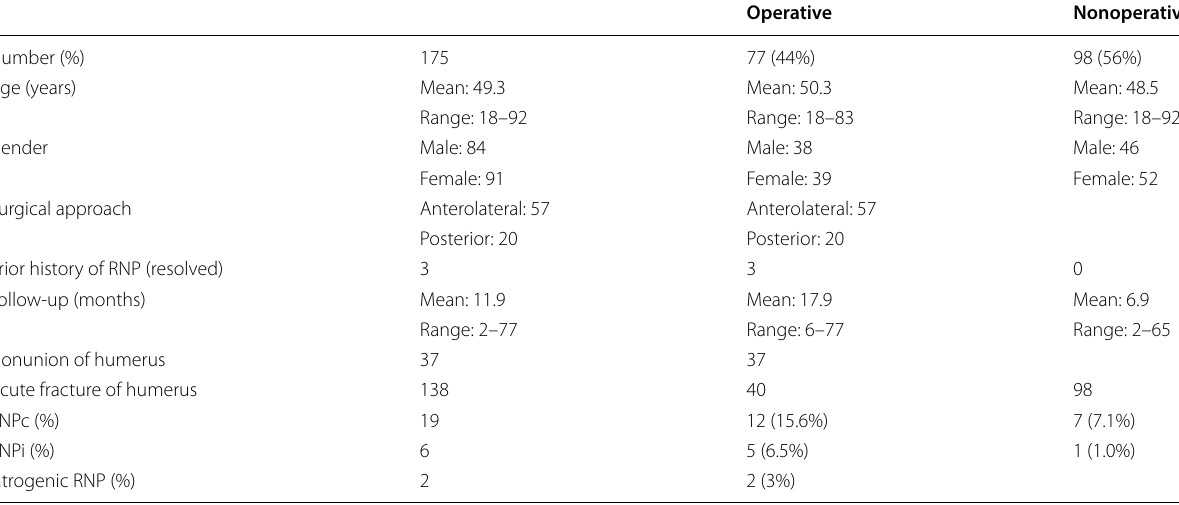
Table 1 Characteristics of study population